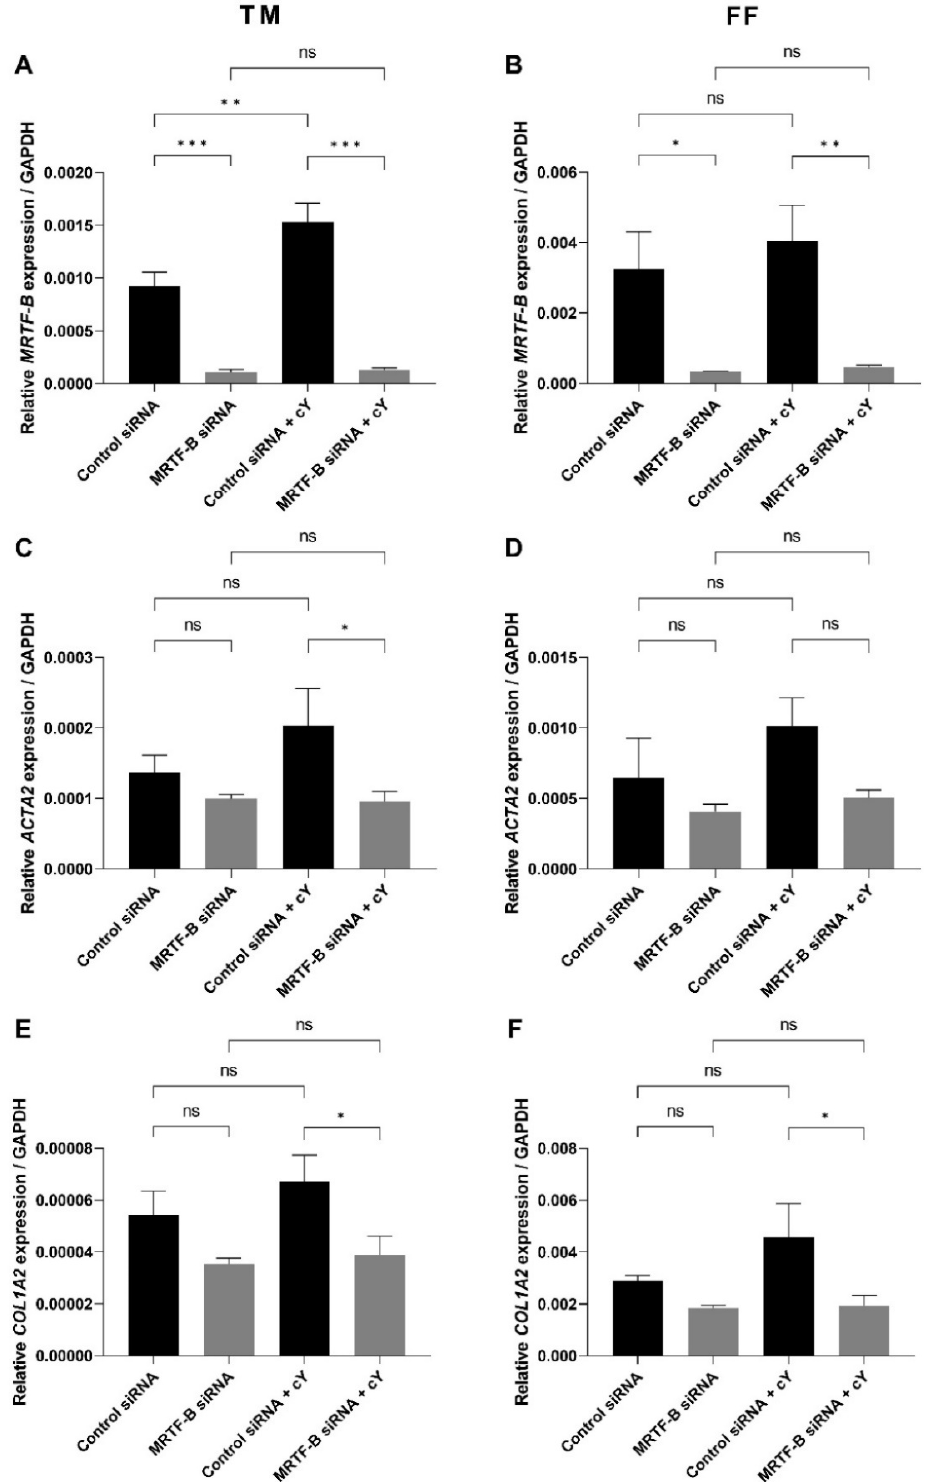
Figure 4. Gene expression of MRTF-B , ACTA2 , and COL1A2 in human TM and FF cells after transfection with four lipid nanoparticles (LNP-Control siRNA, LNP-MRTF-B siRNA, LNP-Control siRNA + cY, LNP-MRTF-B siRNA + cY). ( A ) MRTF-B expression in TM cells. ( B ) MRTF-B expression in FF cells. ( C ) ACTA2 expression in TM cells. ( D ) ACTA2 expression in FF cells. ( E ) COL1A2 expression in TM cells. ( F ) COL1A2 expression in FF cells. Results represent mean ± SEM. n = 3. *, p < 0.05; **, p < 0.01; ***, p < 0.001; ns, not significant.